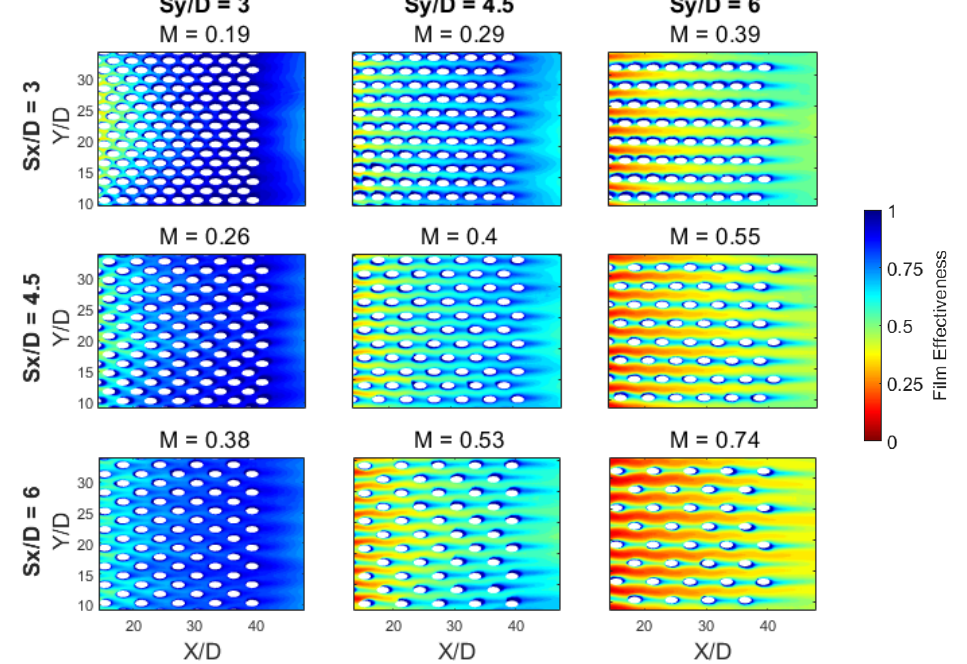
Figure 12. Experimental film effectiveness contours for m ∗ ≈ 3.2. The blowing ratio ( M ) of each geometry is displayed above each contour plot. High porosity geometries form saturated films, leading to uniform and almost complete protection. For lower hole counts, higher blowing ratio leads to jet liftoff, reducing film